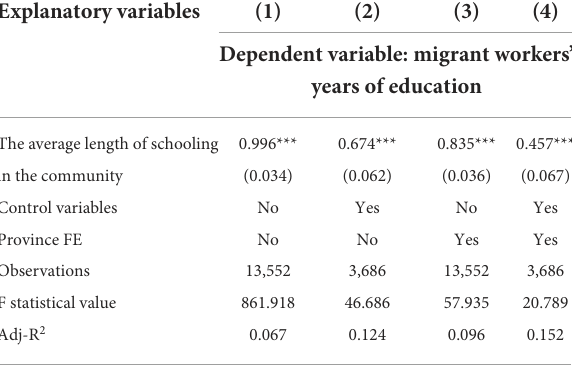
TABLE 4 Instrumental variable test (1): correlation test